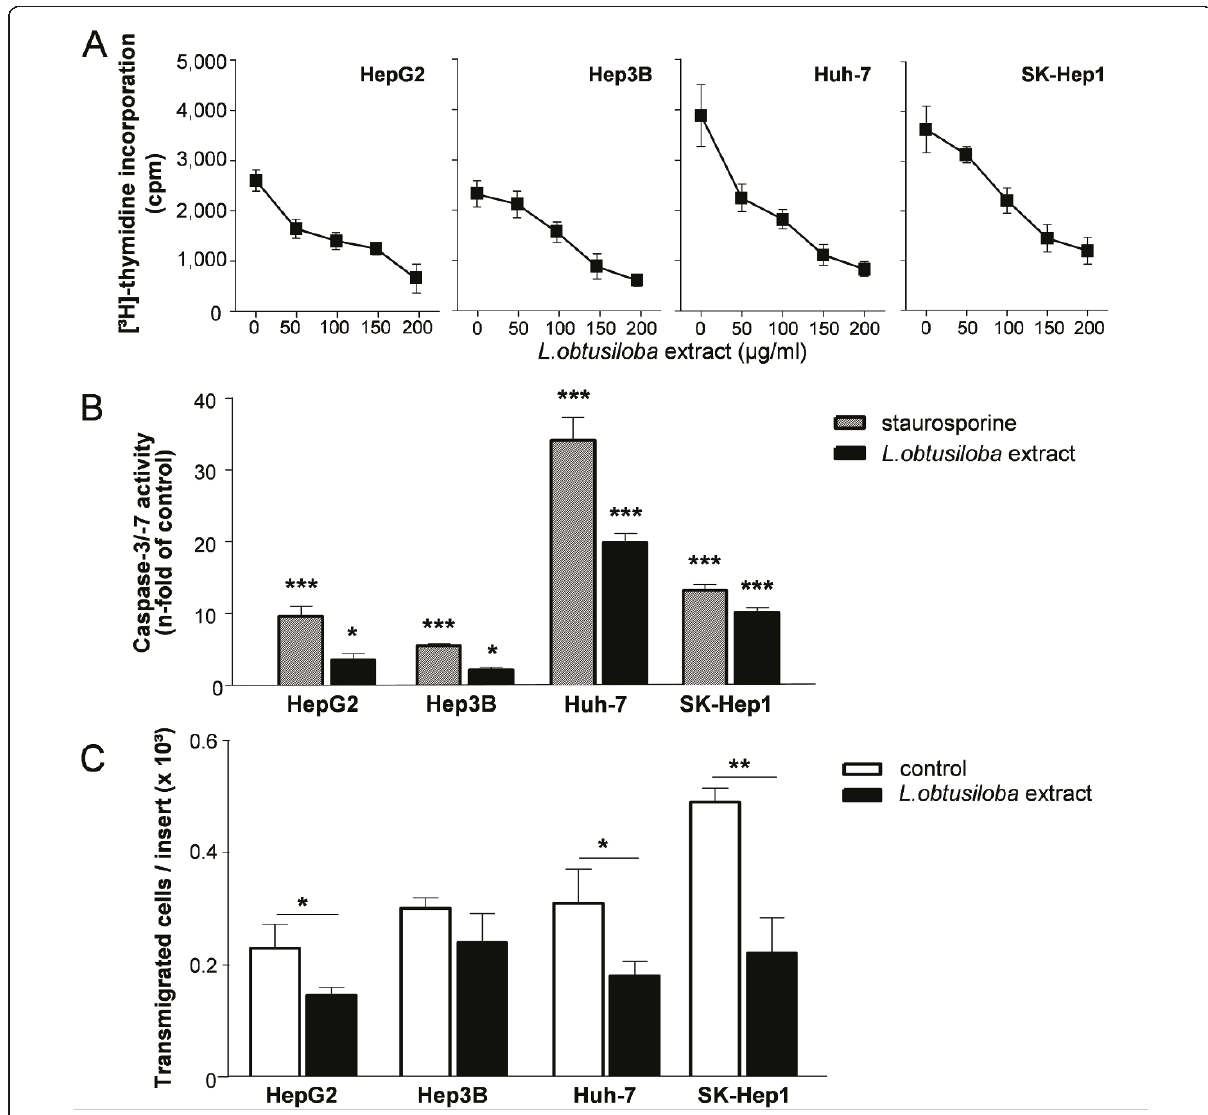
Figure 1 Proliferation, apoptosis and invasion of HCC cell lines treated with L.obtusiloba extract . (A) Cell cycle synchronized HepG2, Hep3B, Huh 7 and SK-Hep1 cells were treated with up to 200 μ g/ml L.obtusiloba extract for 24 h. Cultures without L.obtusiloba extract served as controls. Proliferation was determined by [ 3 H]-thymidine incorporation within the last 4 h of the culture. Mean values ± SD of three parallel measurements. (B) HCC cells were incubated with 100 μ g/ml L.obtusiloba extract for 24 h. Cultures without additives or with 100 nM staurosporine served as negative or positive controls, respectively. Enzymatic activities of caspase-3/7 were determined from cell lysates by fluorogenic substrate conversion. Shown are the mean values ± SD of four parallel measurements. (C) HCC cells were allowed to invade membranes coated with basement collagen in the absence or presence of 100 μ g/ml L.obtusiloba extract. After 24 h, transmigrated cells were stained with crystal violet and numbers were counted. Shown are the mean values ± SD of three independent experiments with four parallel measurements.*P < 0.05, **P < 0.01, ***P <